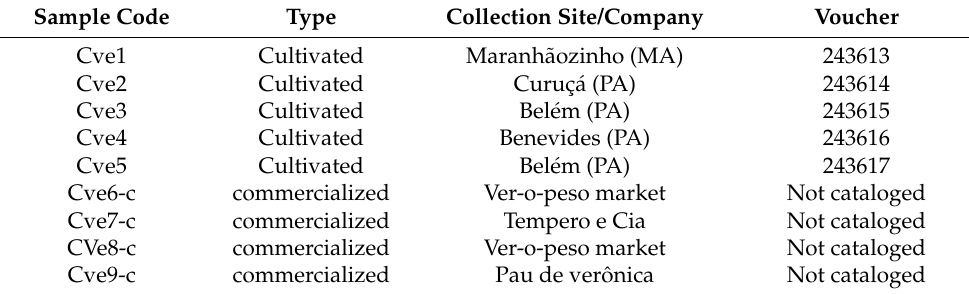
Table 3. Data from cultivated and commercial Cinnamomum verum